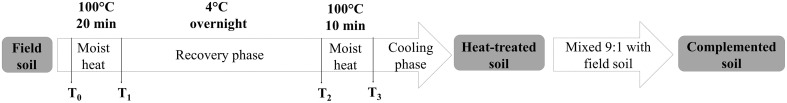
Processing scheme of the soil heat-treatment and complementation used in this study for the agricultural field soil samples. The same procedure was followed for both unamended soil and soil amended with composted almond shells. T0–3 indicates sampling points to perform bacterial and fungal plate counts.